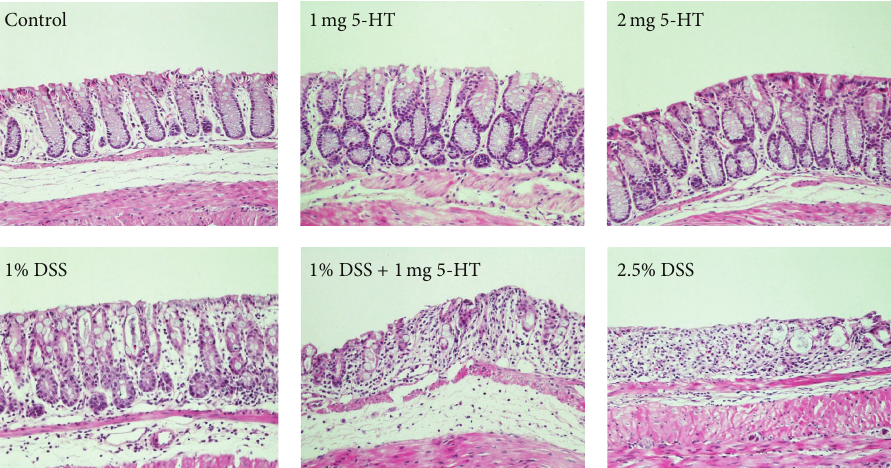
Figure 2: Histopathological analysis of mouse colon treated with 5-HT or/and DSS. There was no colitis in control group ( 𝑛 = 8 ) or alone receiving 1.0 mg/kg ( 𝑛 = 9 ) or 2.0 mg/kg 5-HT ( 𝑛 = 9 ). Mild colitis was in mice treated with 1.0% DSS ( 𝑛 = 14 ). Both mice receiving 1.0% DSS plus 1.0mg/kg 5-HT ( 𝑛 = 12 ) and 2.5% DSS ( 𝑛 = 7 ) had significant severe colitis, demonstrating the increased number of infiltrating inflammatory cells, crypt loss, and erosion of the mucosa and submucosa.